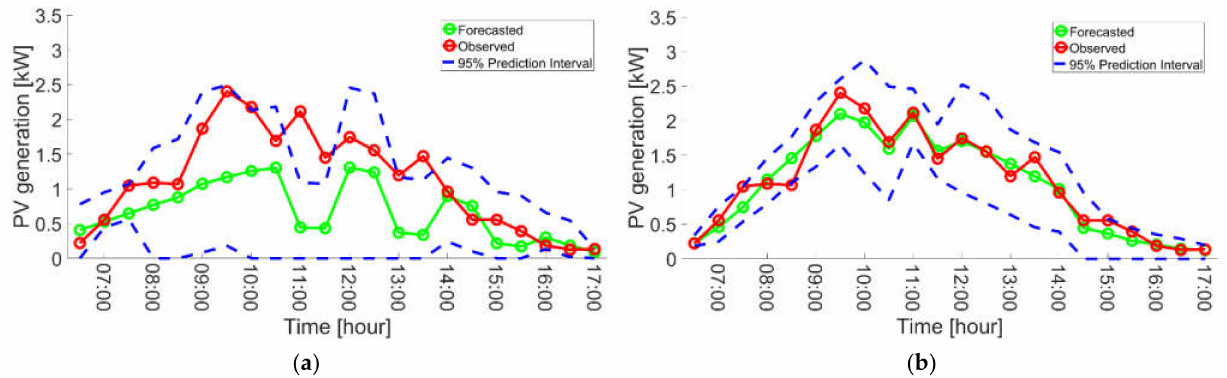
Figure 9. Improvement of forecasted PV generation for PV (iii) on 10 July 2014; the worst RMSE by the single PV forecast model among 30 days performances. ( a ) Single PV forecast model for PV (iii) (RMSE = 0.667 kw). ( b ) Multiple PV forecast model for PV (iii) (RMSE = 0.165 kw).